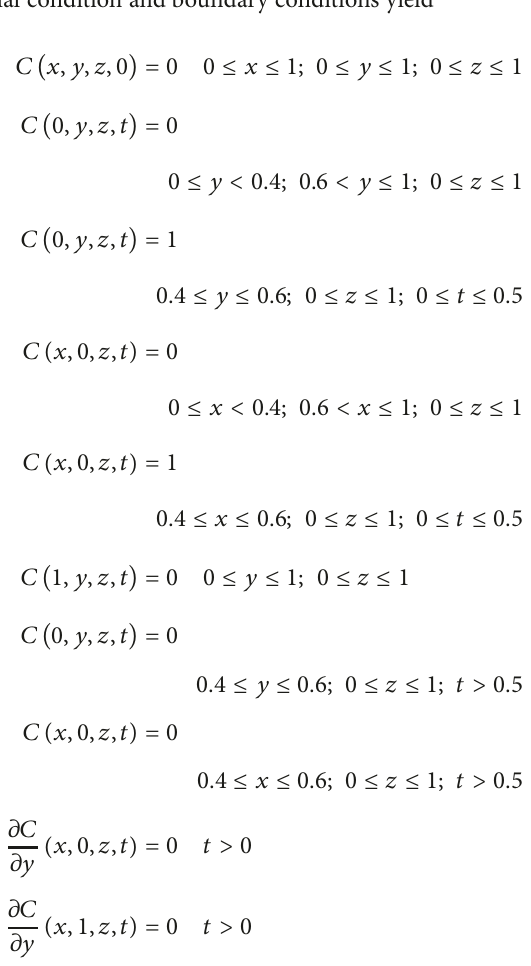
surface and the bottom of the box will be sea floor and satisfy (𝜕𝐶/𝜕𝑧)(𝑥, 𝑦, 𝐻, 𝑡) = 0 and (𝜕𝐶/𝜕𝑧)(𝑥, 𝑦, 0, 𝑡) = 0. Other initial condition and boundary conditions